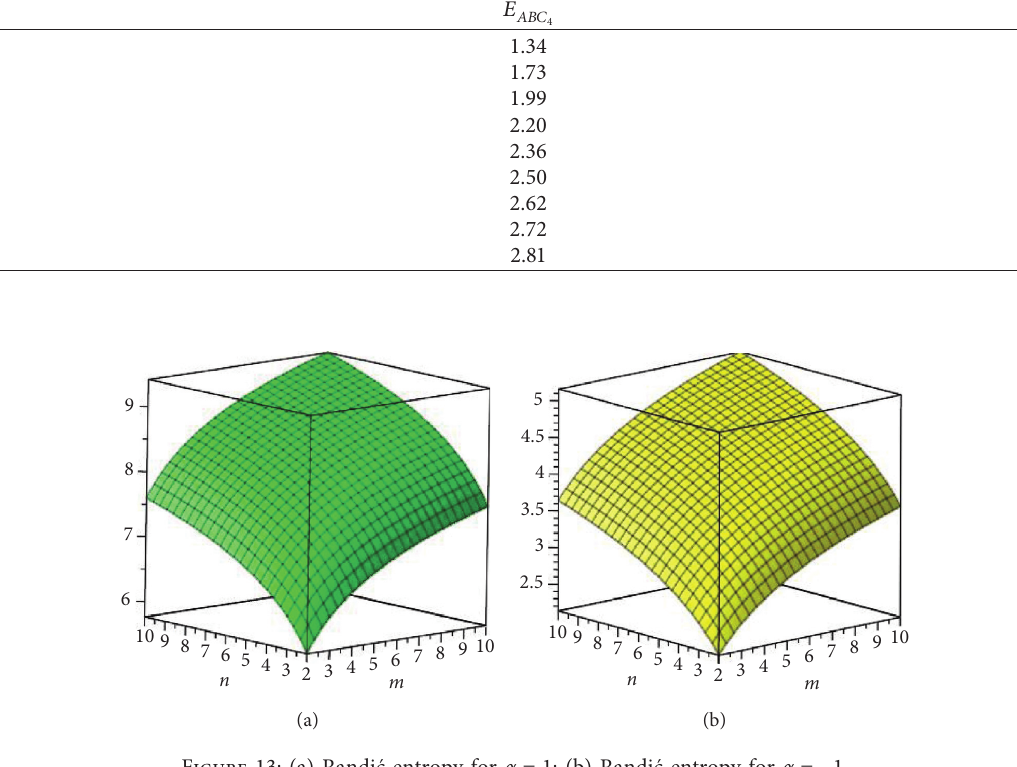
Figure 13: (a) Randi´c entropy for α � 1; (b) Randi´c entropy for α � − 1.